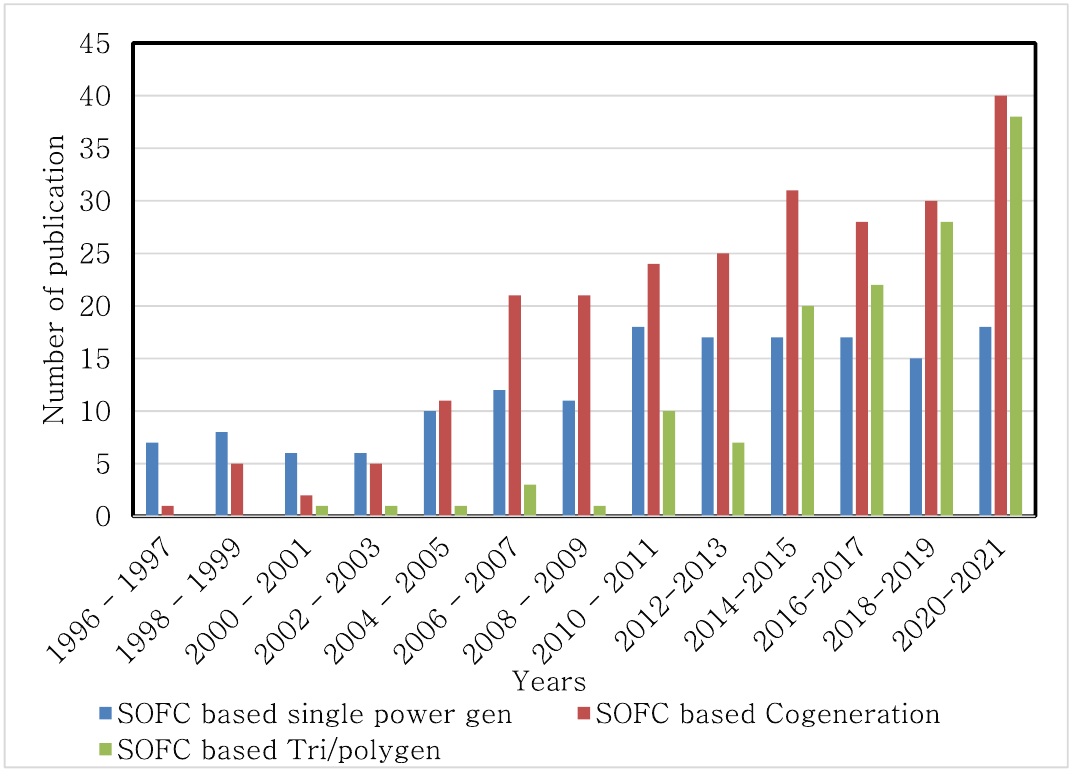
Figure 6. The trend of publication numbers for SOFC power generation in residential applications.